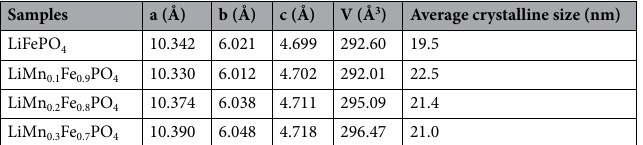
Table 1. Lattice parameters of Mn-doped olivine